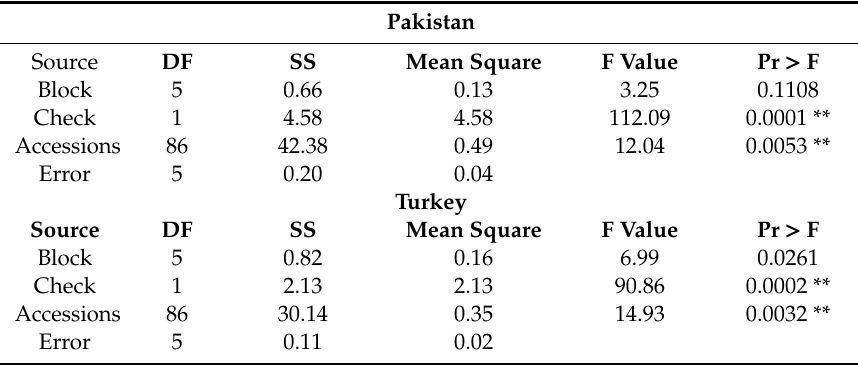
Table 1. Analysis of variance for 100-seed weight of sa ffl ower